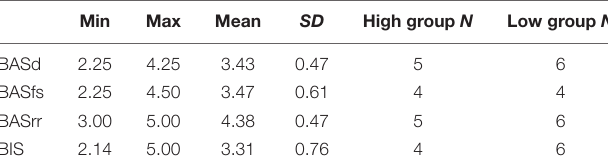
TABLE 2 | BIS-BAS descriptive statistics and number of participants included in the high or low BIS-BAS